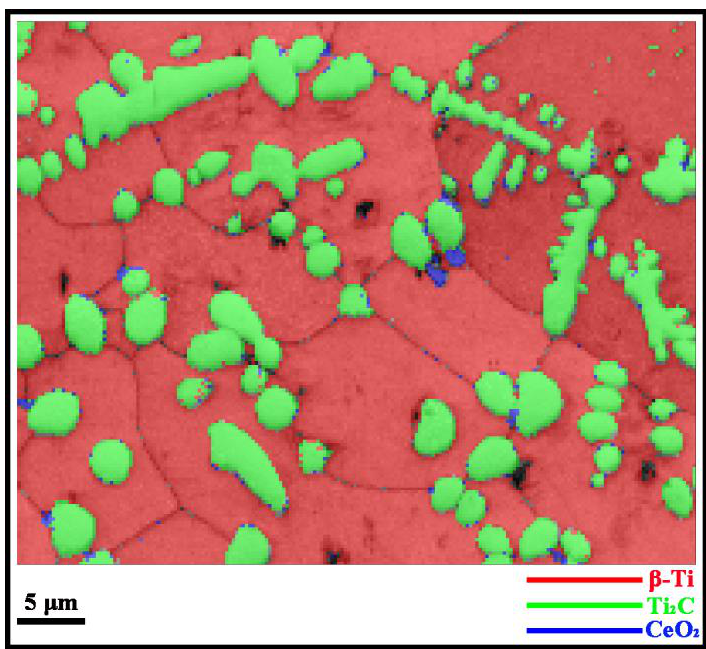
Figure 8. The phase map of the 2 wt.% CeO 2 composite coating.